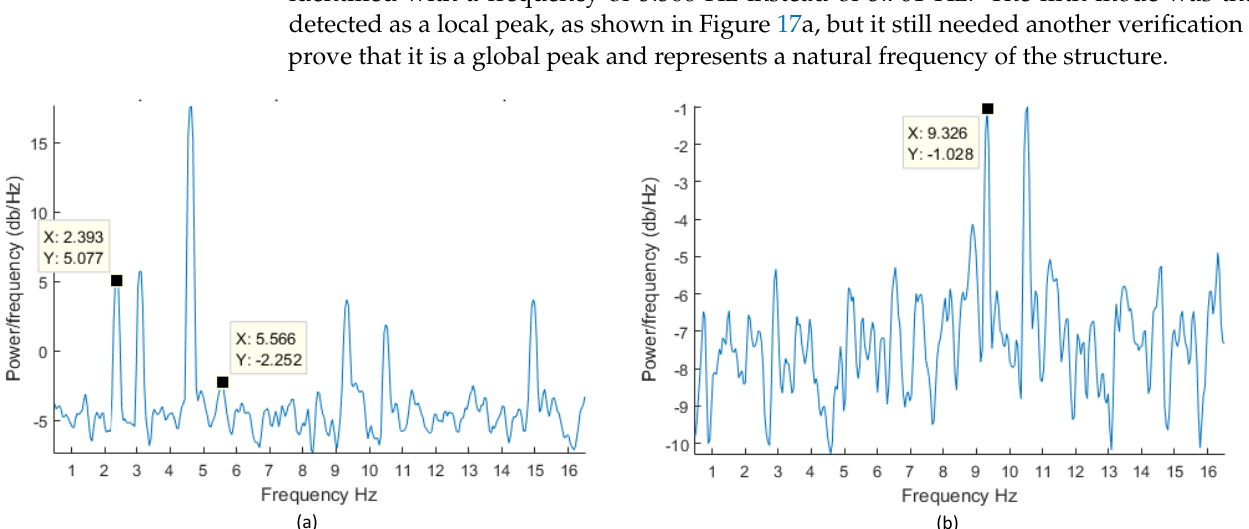
Figure 17. Estimated PSD of Sensor 1 of the noisy data after changing default settings. ( a ) Channel X. ( b ) Channel Z.